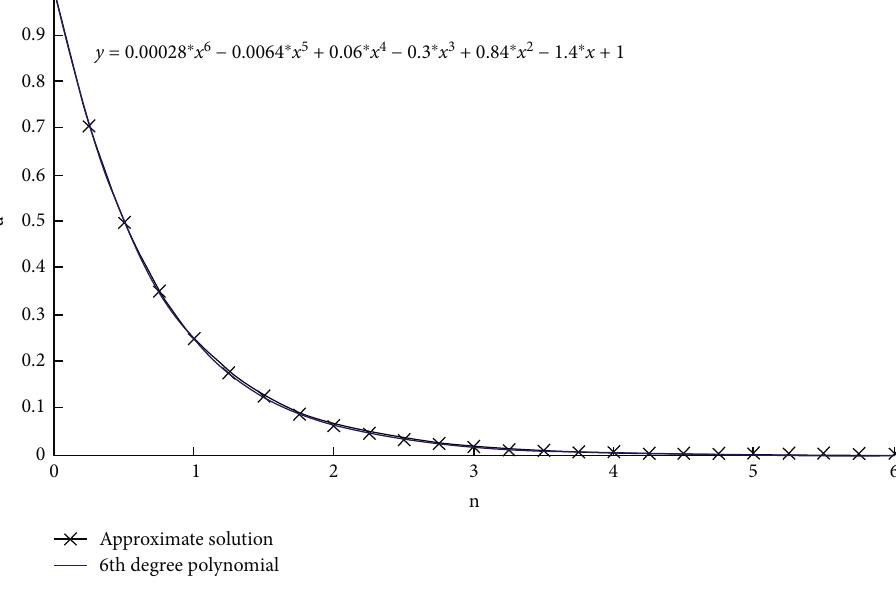
Figure 2: Sixth-degree polynomial fi t with real part of velocity pro fi le.